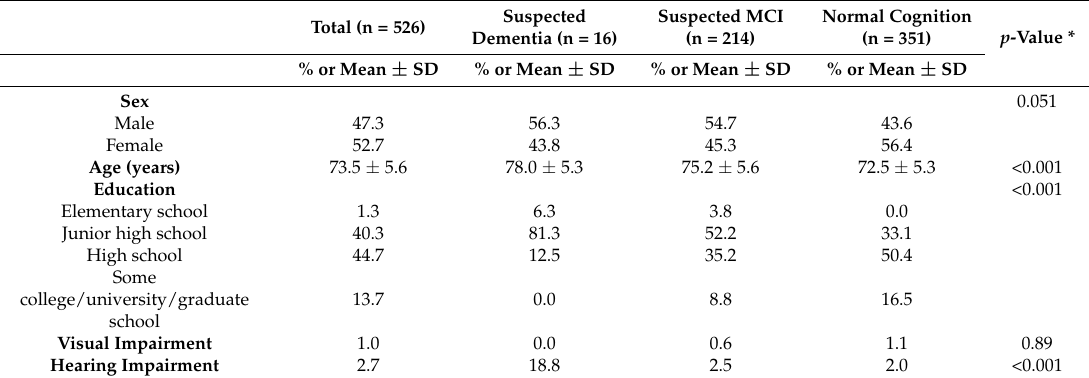
Table 1. Characteristics of all participants included in the analysis along with a breakdown of those categorized with suspected cognitive impairment using established cut-off scores on the standardized Mini-mental State Examination.